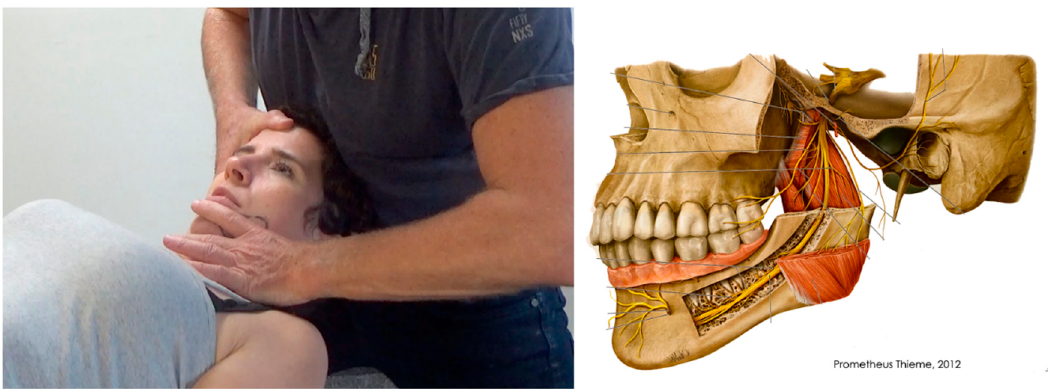
Figure 2. Performance of the neurodynamic test of the mandibular nerve: upper cervical flexion, upper lateral flexion toward the contra ‐ lateral side, mandible lateral deviation in 2.5 cm mouth opening to the contra ‐ lateral side. Right figure reprinted with permission from Hals und Neuroanatomie. In: Prometeus K (ed). 4th edition. Auflage: Thieme; 2015. Pg. 123.